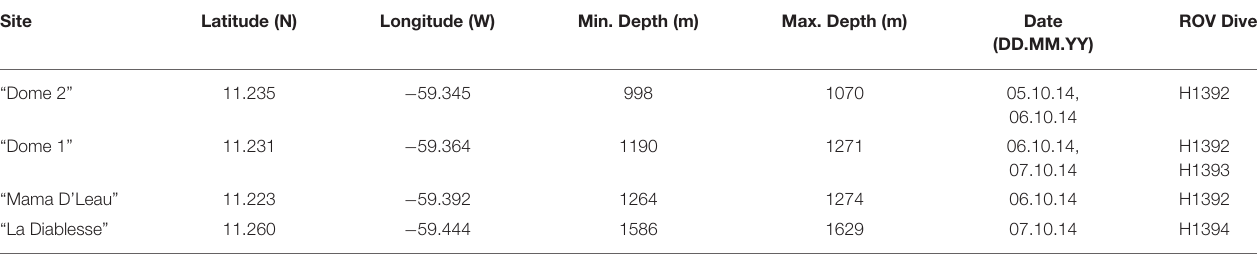
TABLE 1 | Sites surveyed during NA054.